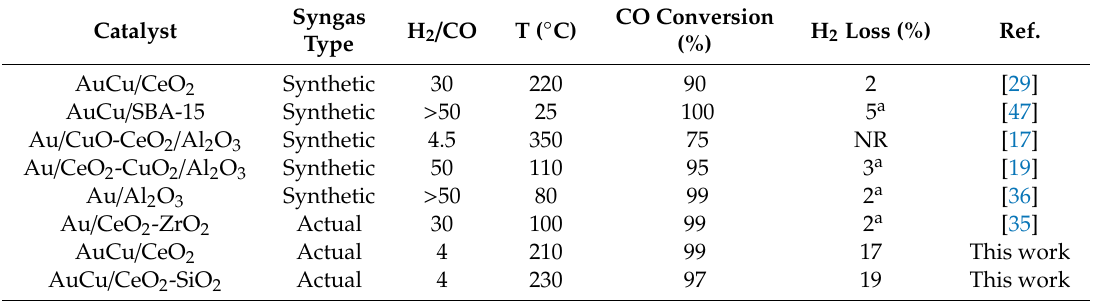
Figure 3. H 2 yield obtained from a system that integrate the ethanol steam reforming (ESR) reactor and the cleanup reactor, where the CO removal is performed with bare supports ( a , b ) and supported 1 wt% Au–1 wt% Cu catalysts ( c , d ). Reaction conditions: SV = 6.5 ± 0.2 L/g cat *min and 0.3 g of the catalytic bed in both reactors. Table 2. Comparison of various catalytic systems for the CO removal using Au–Cu